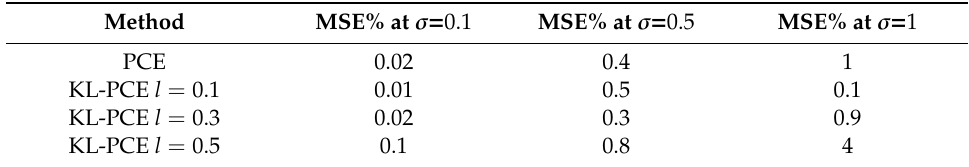
Table 4. PCE vs MC variances